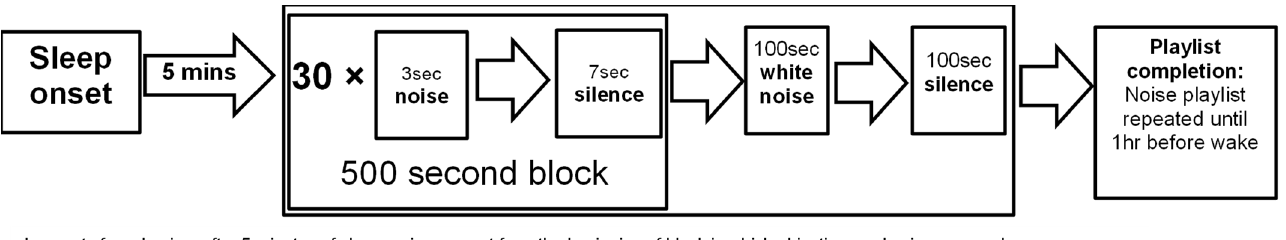
Figure 1. Sleep laboratory noise protocol.